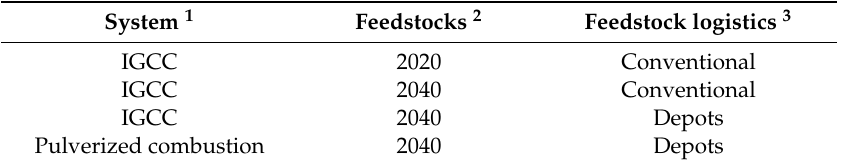
Figure 2. Biomass supplies (million tonnes per year) used in this analysis, by feedstock type, select roadside cost (i.e., including production and harvest but excluding transportation or processing), and year (near term and long term represented by 2020 and 2040, respectively). Source: USDOE [6], data from https://bioenergykdf.net/bt16-2-download-tool/county. Quantities of resource types within categories are reported in Tables S2 and S3 in the Supplementary Materials. Table 2. Scenarios explored in this analysis. Each scenario includes nine simulations representing 10% to 90% of potential CO 2 capture in 10%